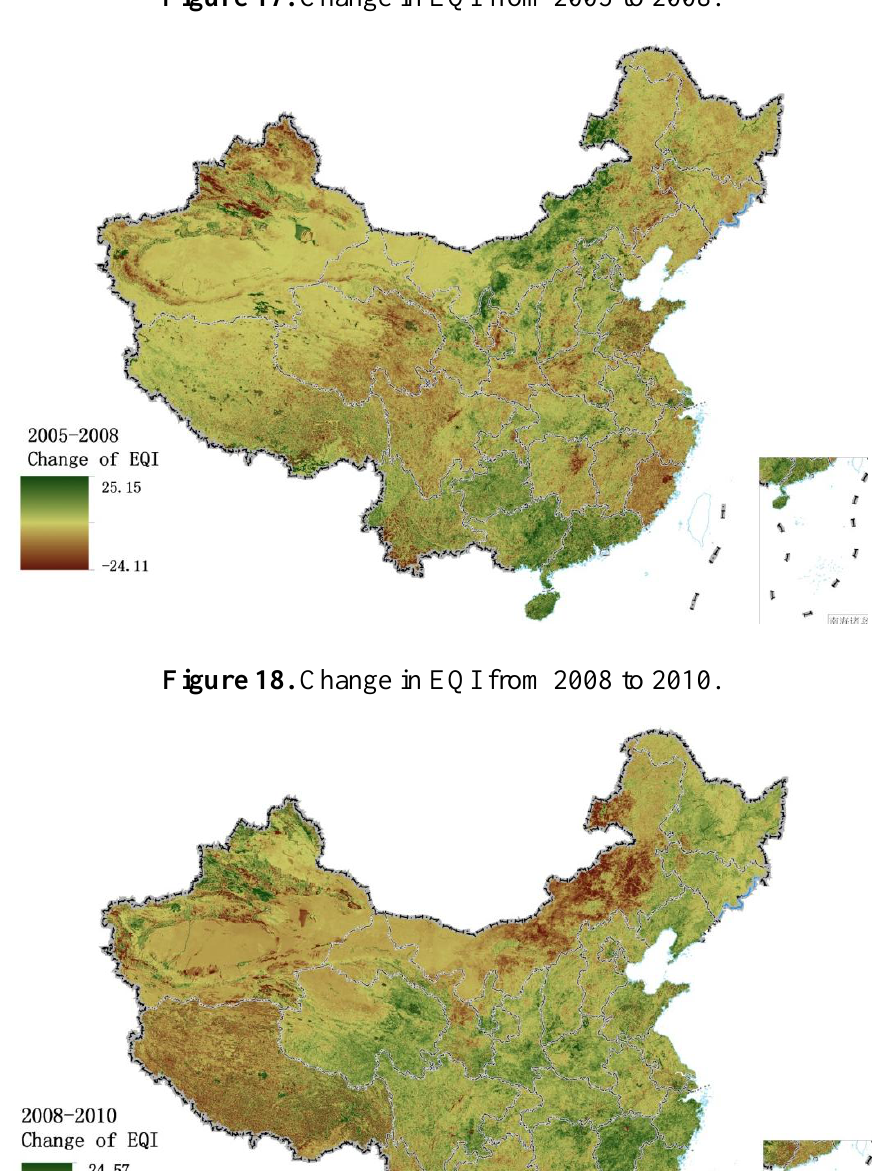
Figure 17. Change in EQI from 2005 to 2008.